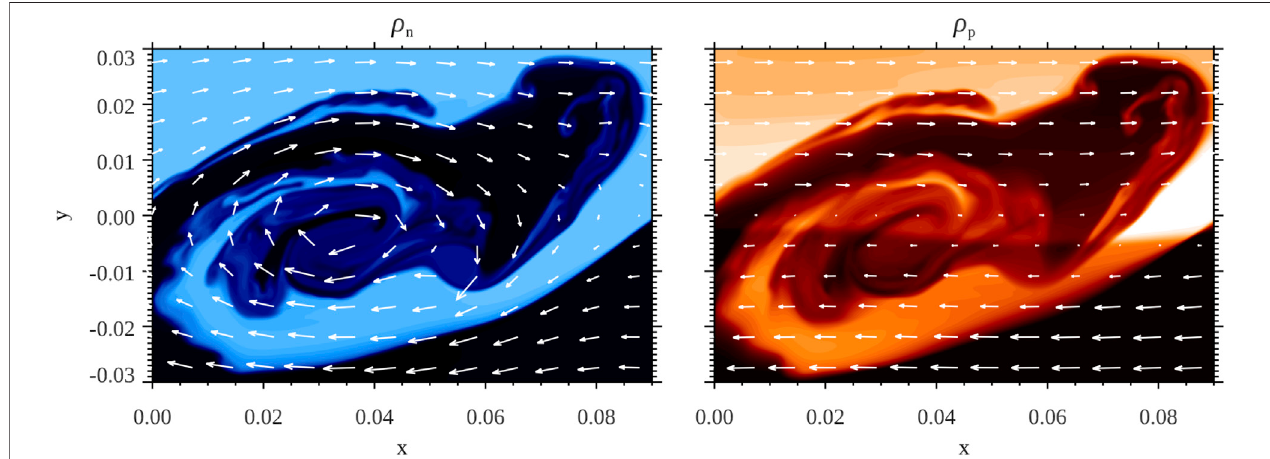
FIGURE4| Neutrals (left) andcharges (right) densitystructuresinasmall-scaleKHivortex.Thewhitearrowsarethecorrespondingvelocity fi elds.Theneutral fl uid shows a clear vortex pattern in velocity that is not seen in the charged fl uid. However, the density distributions are similar in the two fl uids because of thermal coupling. Reprinted from Hillier (2019), with the permission of AIP